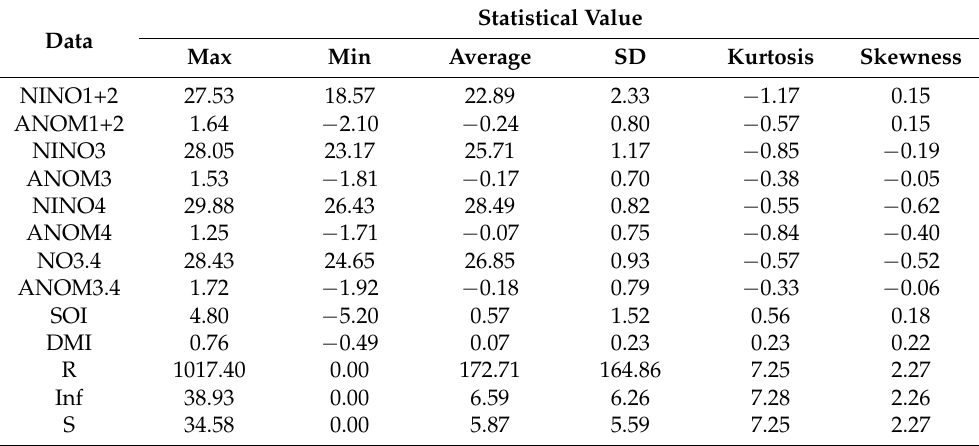
Table 3. The statistical analysis of data